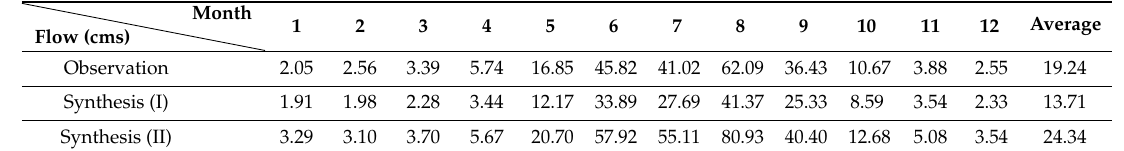
Table 5. Comparison of historical and synthesis flow data.